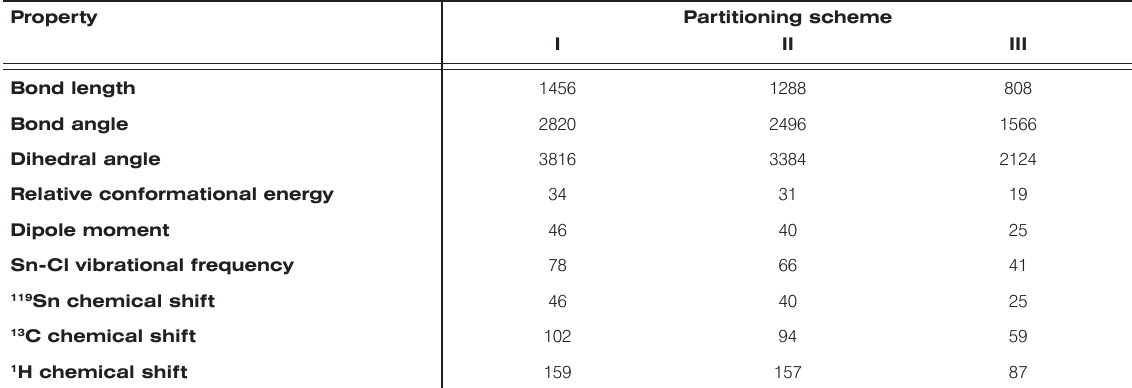
Table 1. Molecular properties of the investigated X ONIOM(B3PW91:HF) with different partitioning schemes.